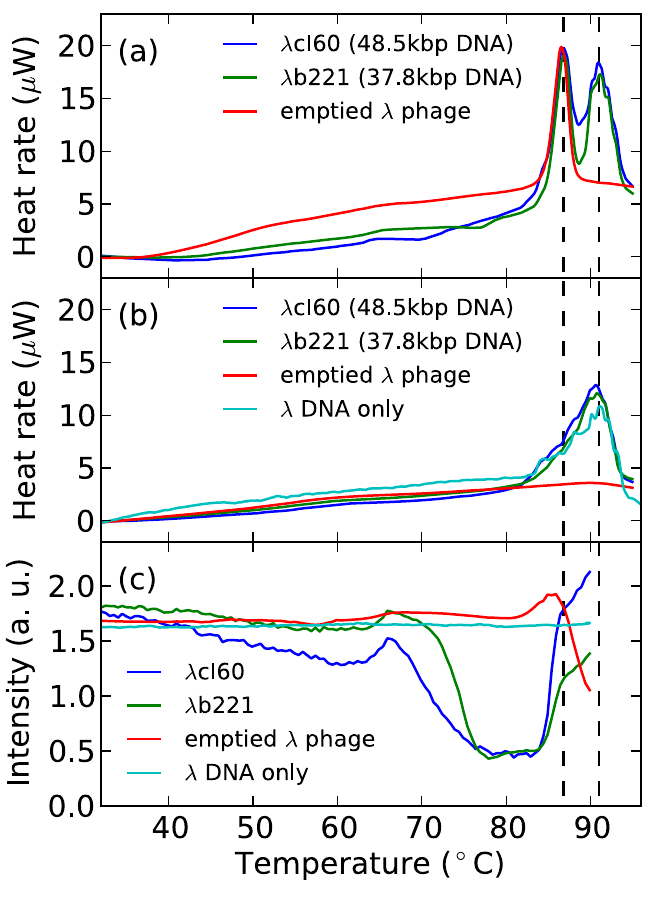
Figure 1. Heat induced structural transitions of l phages. (a) Differential Scanning Calorimetry (DSC) data of the two intact l phage strains and the emptied l phage in the TM buffer. The two dashed vertical lines denote temperatures of 86.8 and 91 u C respectively. (b) The second DSC heating scan for the same three phage solutions as in (a), with the addition of DSC data for l DNA only. Note the disappearance of the capsid melting peak around * 87 u C. (c) Static light scattering (SLS) at the scattering angle of 90 u for solutions of the l phage constructs and l DNA